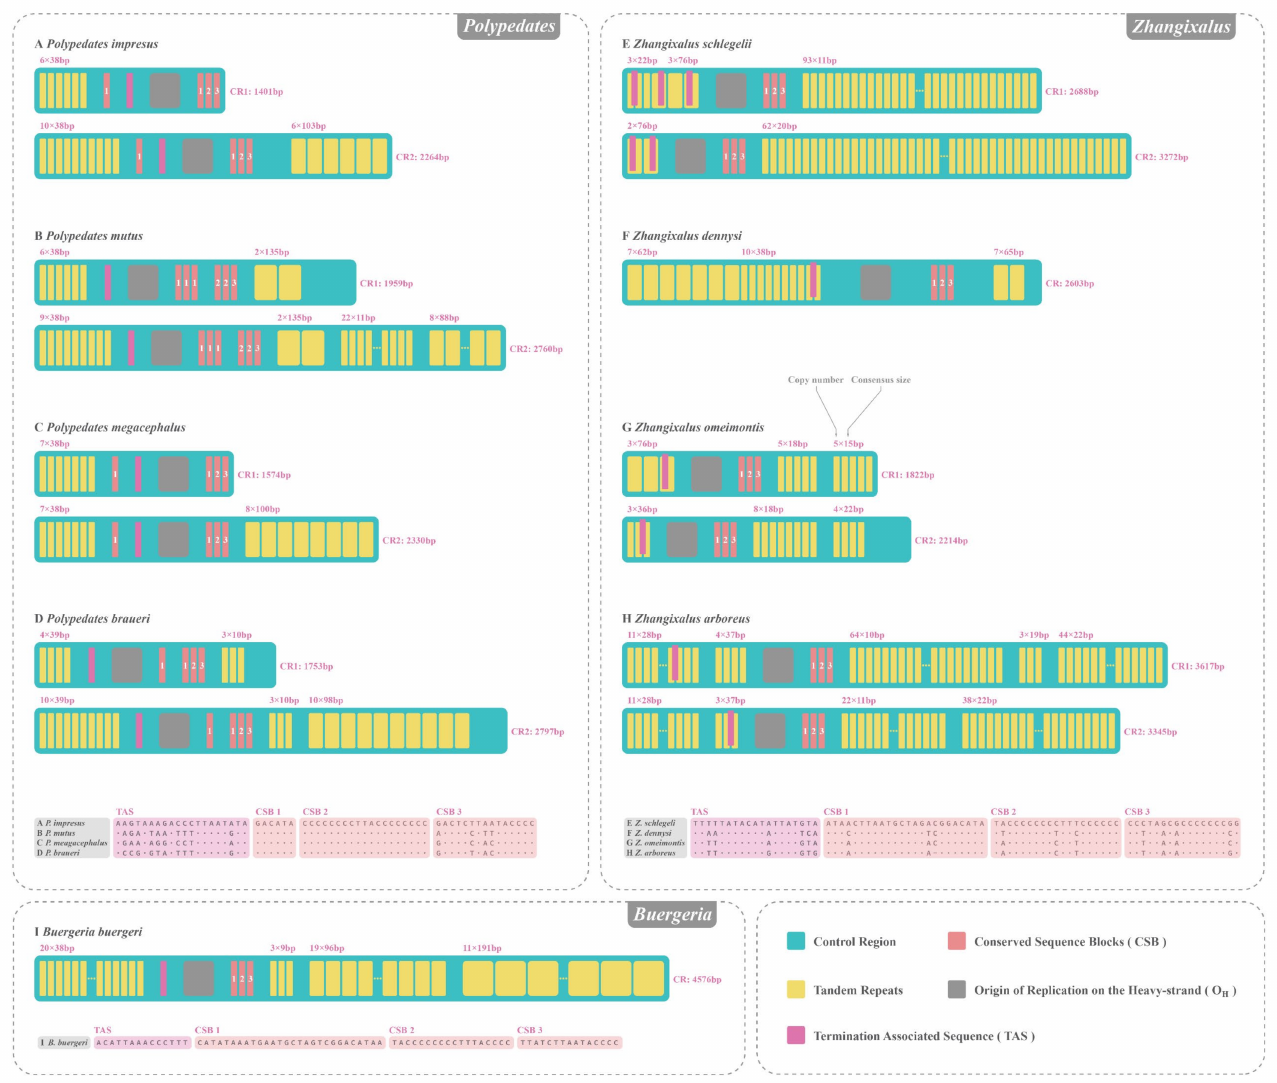
Figure 5. Mitogenome control region (CR) structure comparison and conservative sequence align- ments of nine rhacophorids. Structures of the CRs and putative termination associated sequences (TAS), conserved sequence blocks (CSB), and tandem repeats are plotted for each